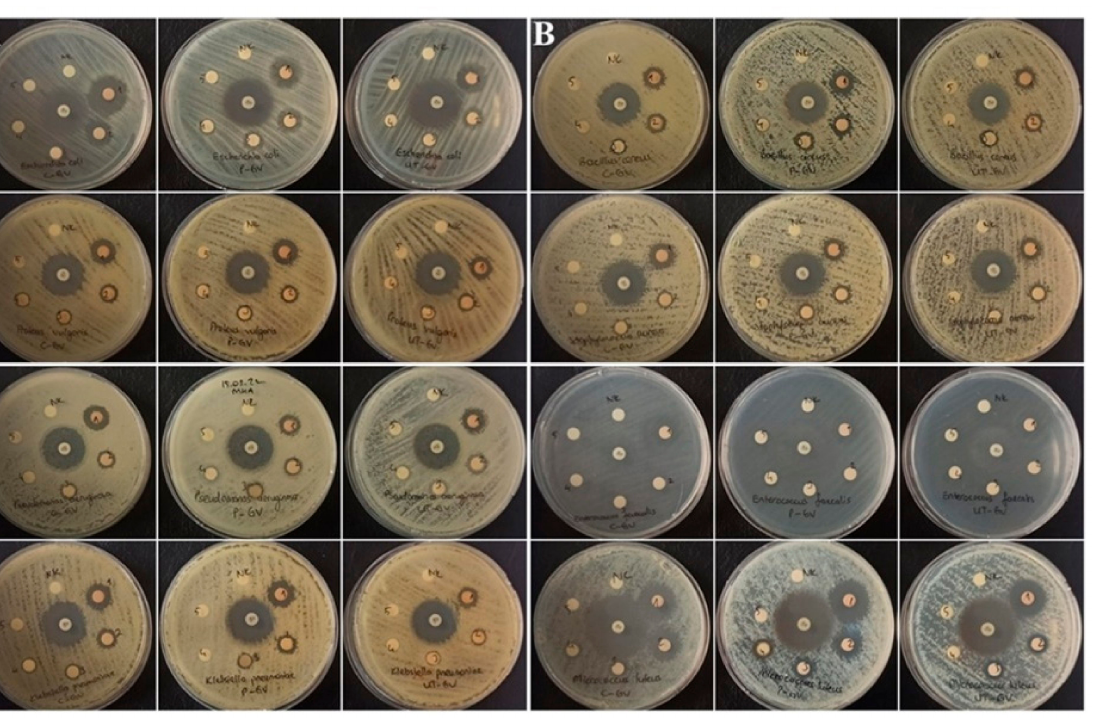
Figure 2. The antibacterial activity of five different concentrations (6.25–100%) of traditional gilaburu vinegar (C- GV), pasteurized gilaburu vinegar (P-GV), and ultrasound-treated gilaburu vinegar (UT- GV) against Gram-negative ( Escherichia coli, Proteus vulgaris , Pseudomonas aeruginosa , and Klebsiella pneumoniae ) ( A ) and Gram-positive ( Bacillus cereus , Staphylococcus aureus , Enterococcus faecalis , and Micrococcus luteus ) ( B )